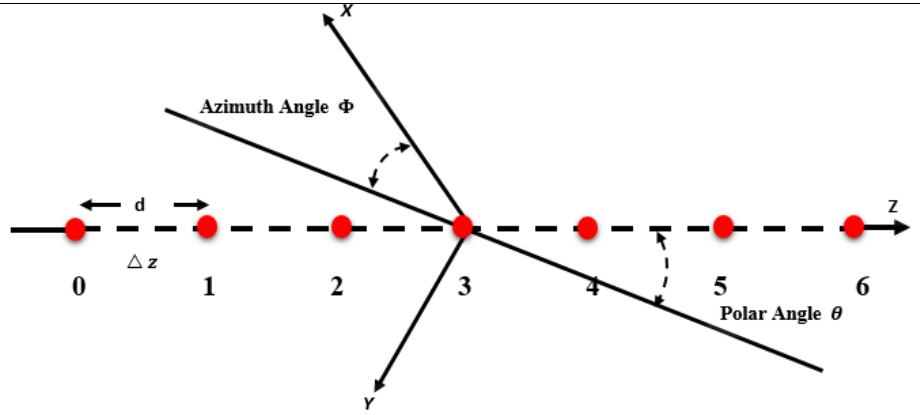
Figure 3. Uniform Linear Arrays of 7-elements located on the z-axis with uniform spacing